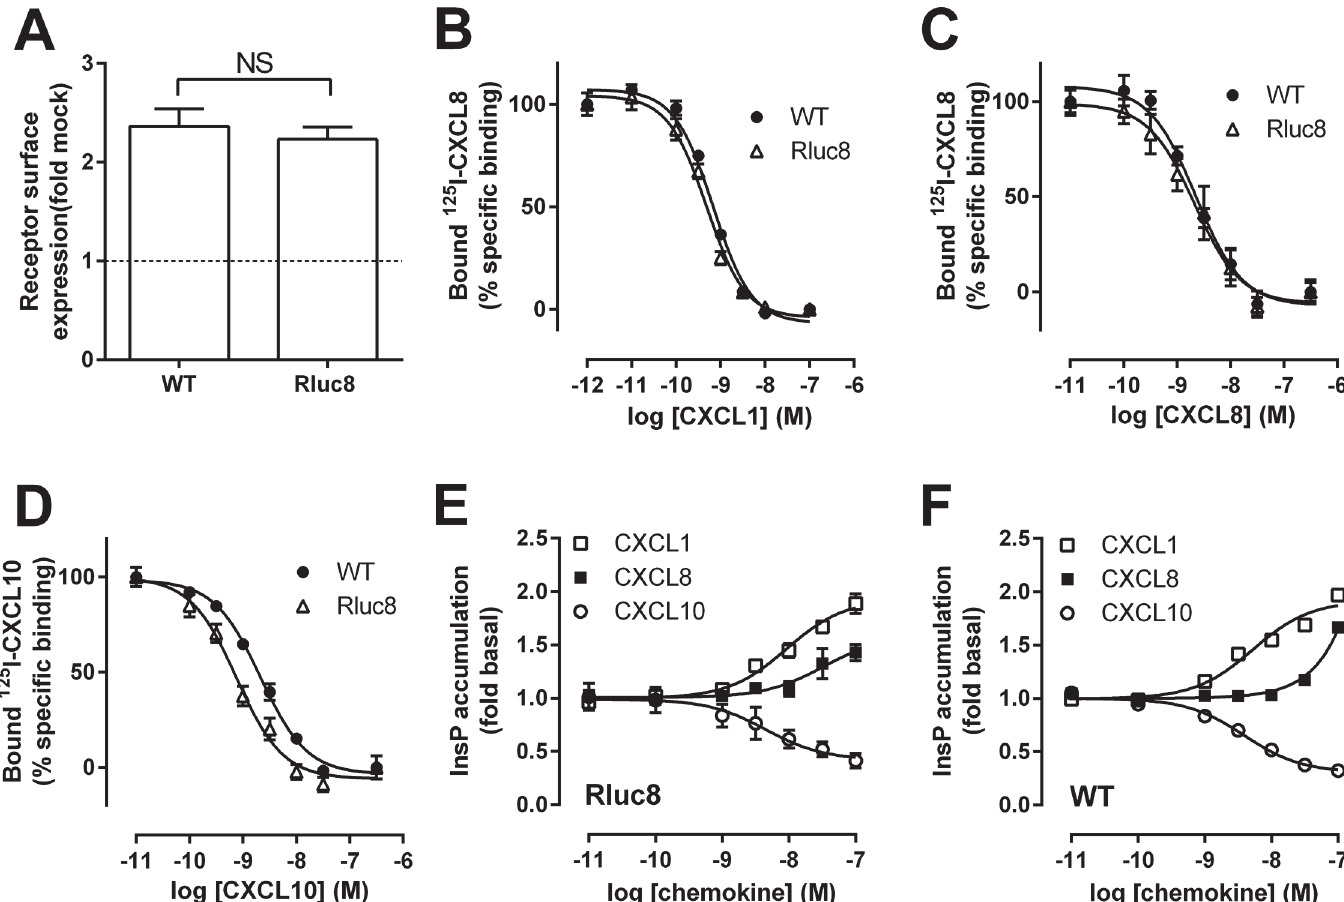
Fig 1. Characterization of ORF74-Rluc8. HEK293T cells were transiently transfected with WT-ORF74 (WT), ORF74-Rluc8 (Rluc8) or empty vector DNA (mock-transfected). (A) Cell surface expression was determined by ELISA. (B-D) Whole cell binding experiments with 100 pM 125 I-CXCL8 (B, C) or 125 I-CXCL10 (D) were performed in the presence of increasing concentrations unlabeled CXCL1 (B), CXCL8 (C) or CXCL10 (D). HEK293T cells transfected with ORF74-Rluc8 (E) or WT-ORF74 (F) were stimulated with increasing concentrations of CXCL1 (open squares), CXCL8 (filled squares) or CXCL10 (open circles) and InsP accumulation was quantified. Data are shown as the mean ± SEM of at least three independent experiments each performed in triplicate and are presented as fold over mock-transfected cells (dotted line) (A), percentage of specific 125 I-CXCL8 (B, C) or 125 I-CXCL10 binding (D) or fold over basal (E, F). Statistical differences in cell surface expression (A) were determined by a Student t test. NS = not